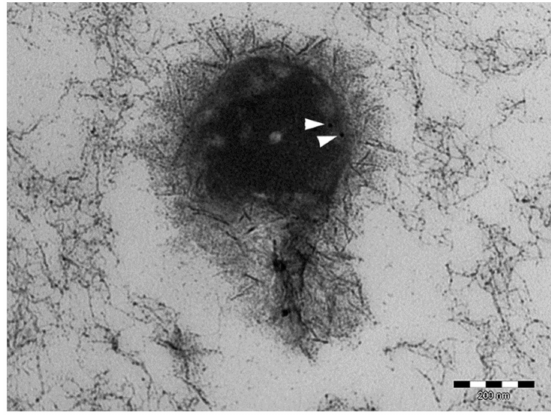
Figure 3. TEM image of ultrafiltered EV. The white arrows indicate the HSP90-reactive gold particles.